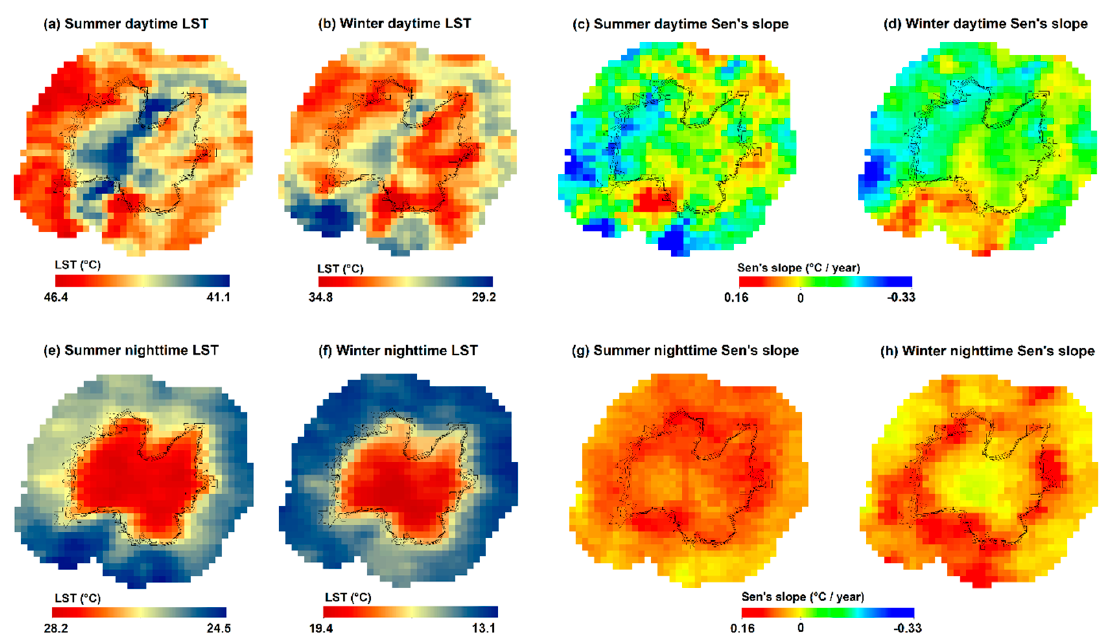
Figure 3. Ahmedabad city and surrounding rural area. Spatial distribution of the LST (average over 2003–2018) for summer daytime ( a ), winter daytime ( b ), summer nighttime ( e ), and winter nighttime ( f ). Sen’s slope of the LST across 2003–2018 for summer daytime ( c ), winter daytime ( d ), summer nighttime ( g ), and winter nighttime ( h ). Dark curves represent the urban boundaries for the years 2003, 2007, 2011, and 2015.